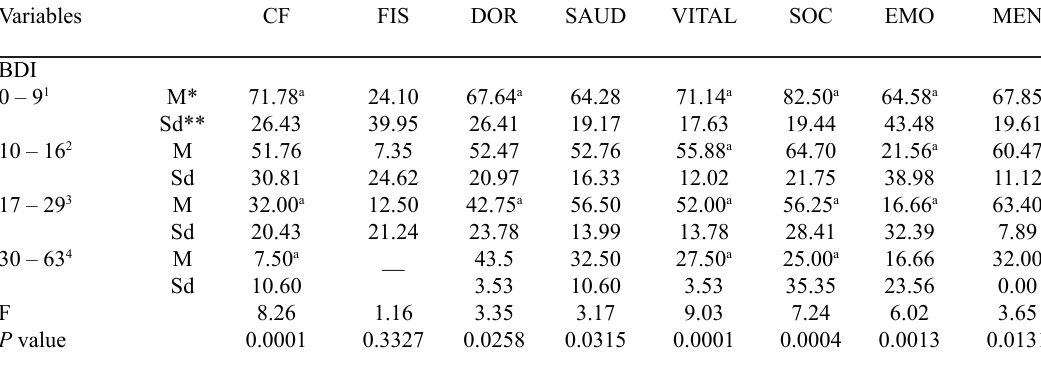
a Equal letters within the same column indicate differences between the means; *Mean; **Standard Deviation; 1